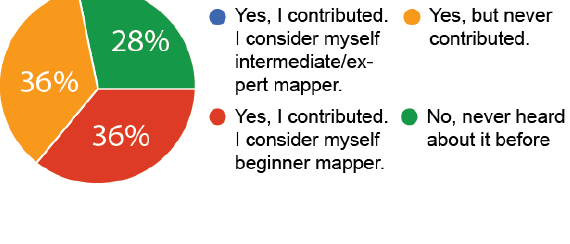
Figure 6. Percentage of students’ knowledge about OpenStreetMap project.